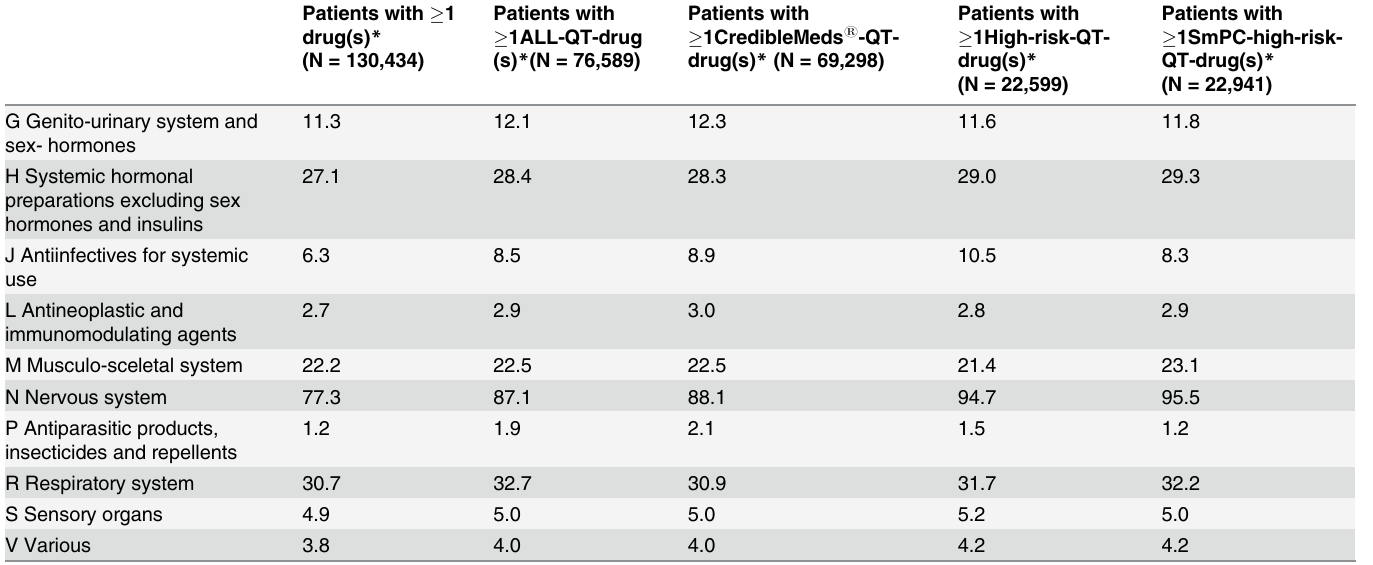
Table 3. Proportion of patients according to the number of drugs of the respective QT-category of risk-classification.